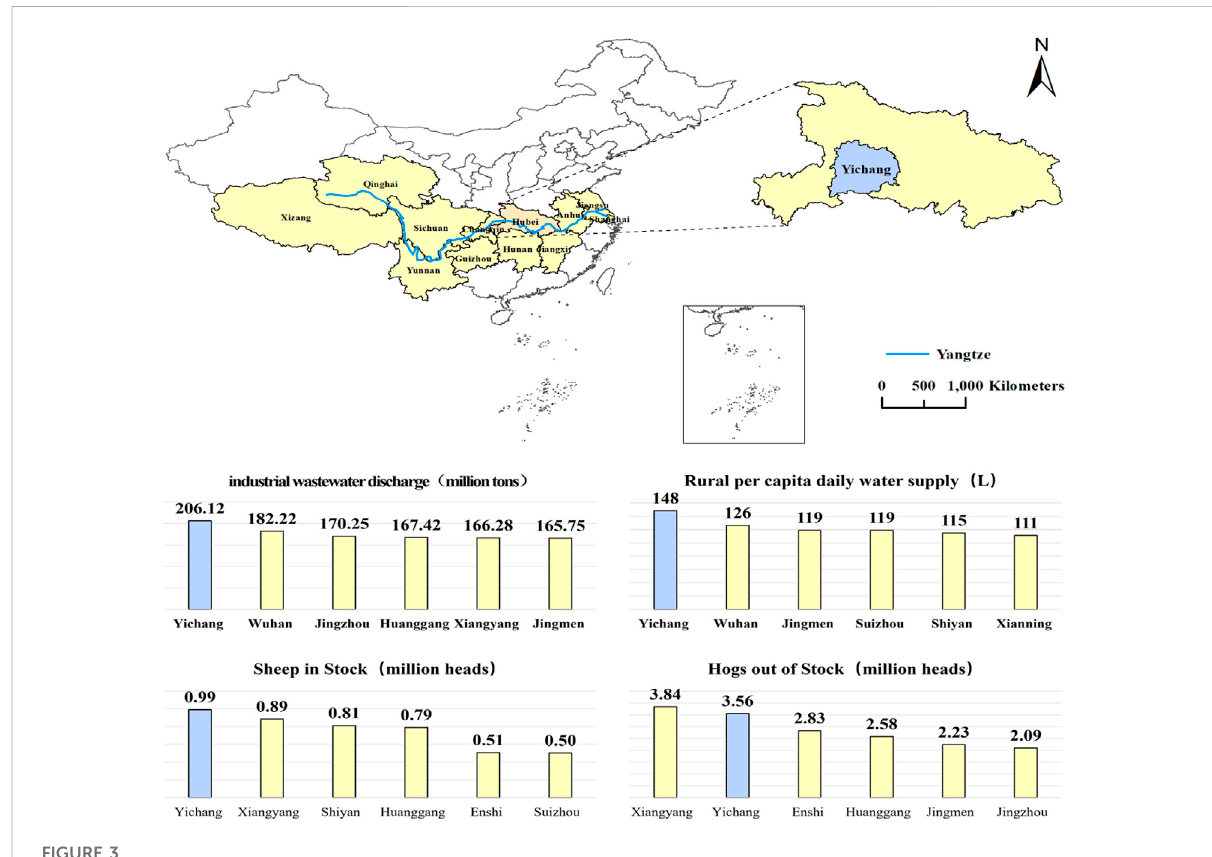
Geographical location of Yichang in Hubei